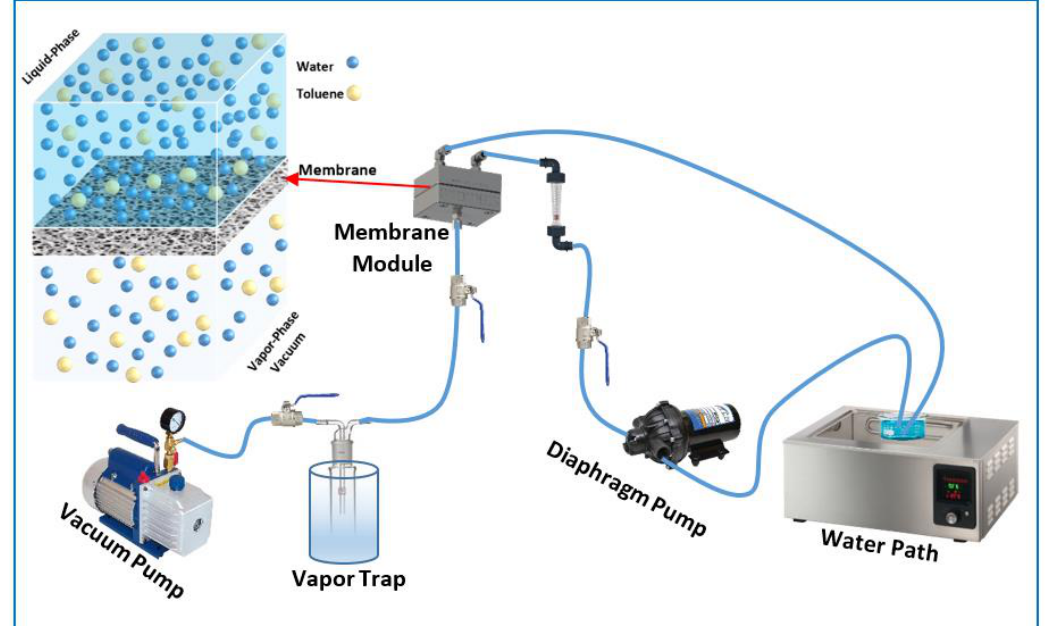
Figure 1. Schematic diagram of the pervaporation process.